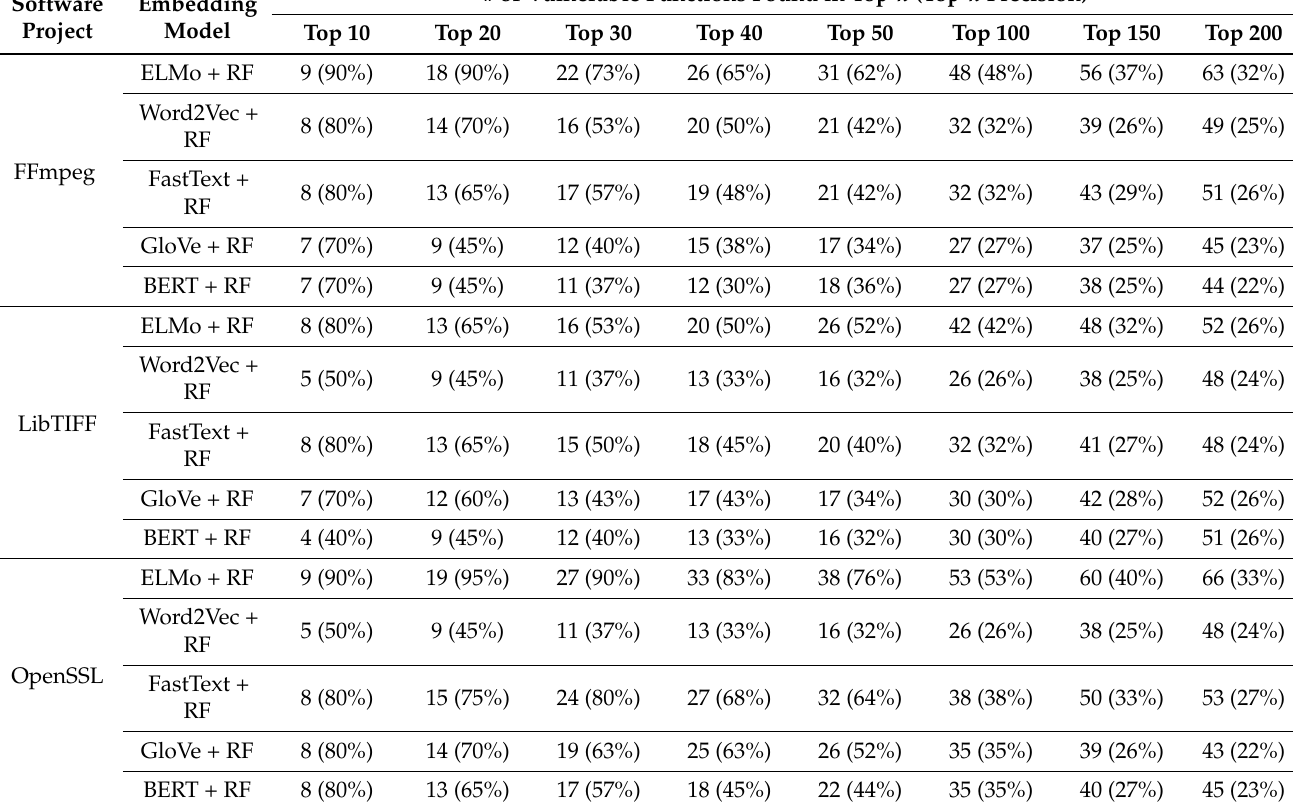
Table 3. The comparison between the ELMo module, Word2Vec, GloVe, FastText and BERT model in terms of their effectiveness of generating representations for source code functions on open source projects: FFmpeg, LibTIFF and OpenSSL. The generated representations are used as features to train a random forest (RF)